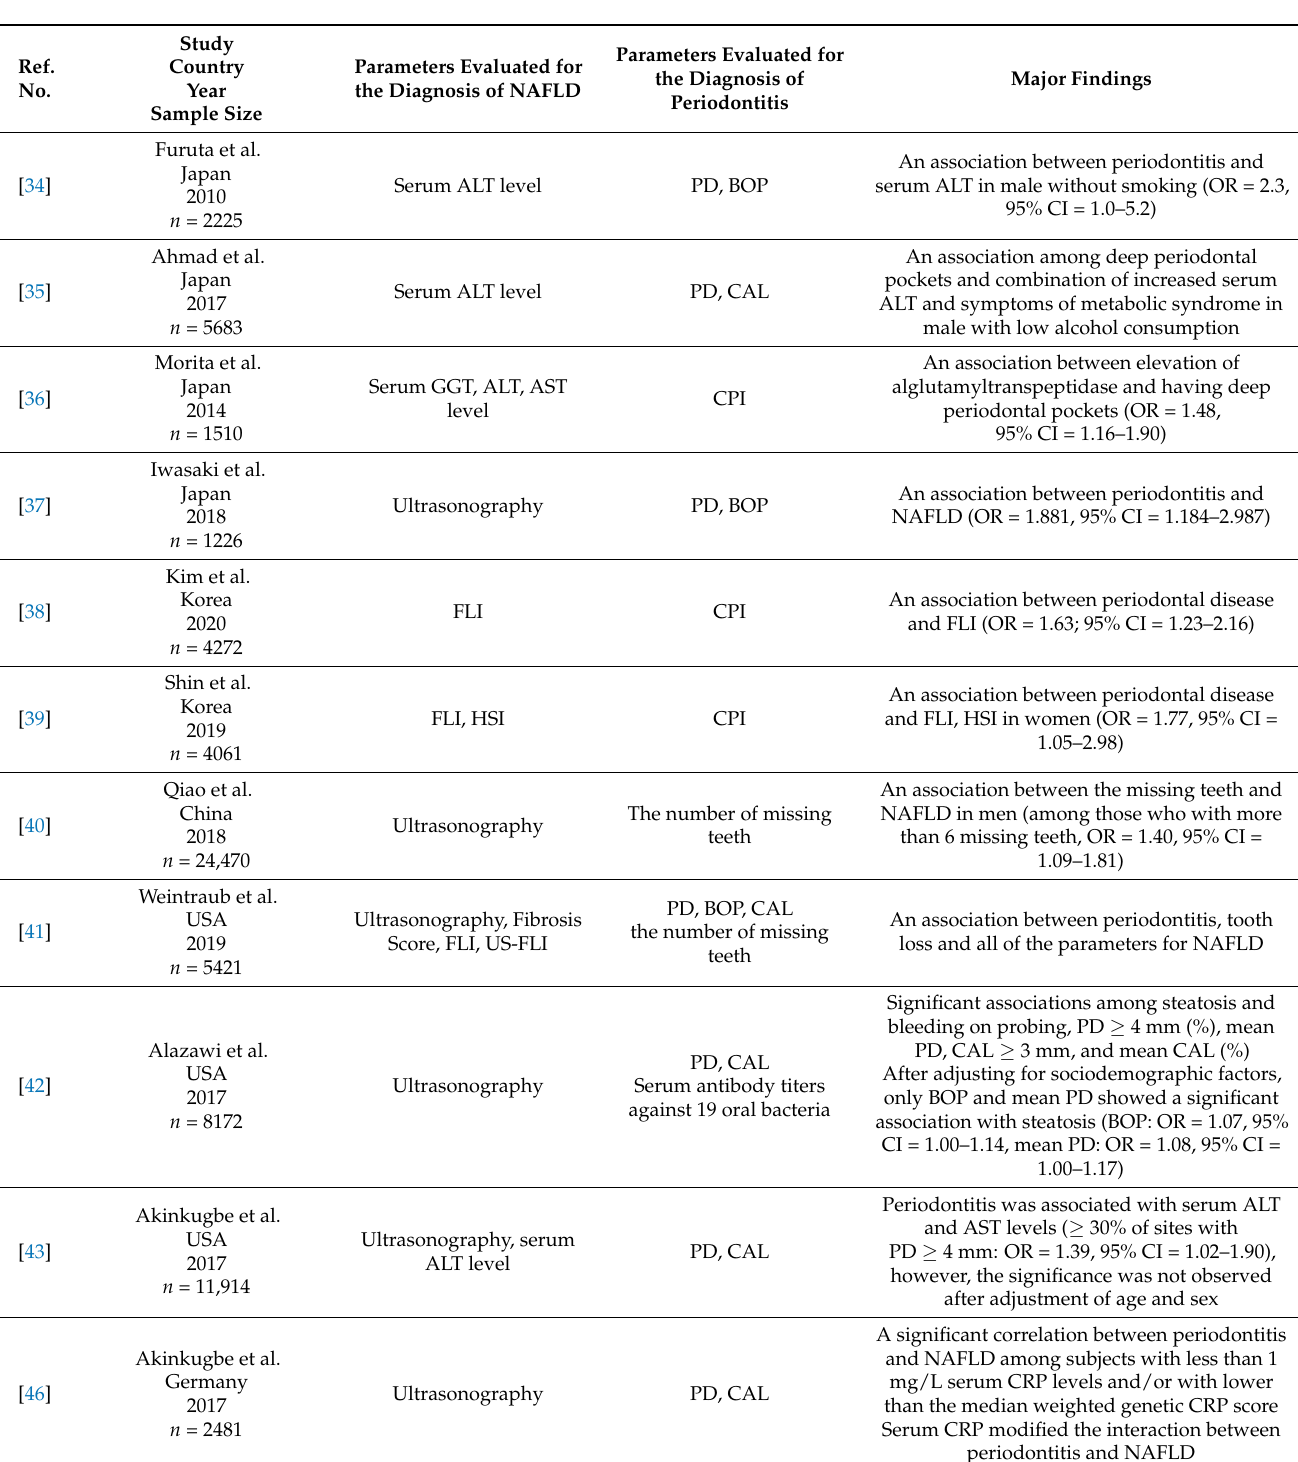
Table 1. Cross-sectional studies regarding the relationship between nonalcoholic fatty liver disease (NAFLD) and periodontal disease. Ref.